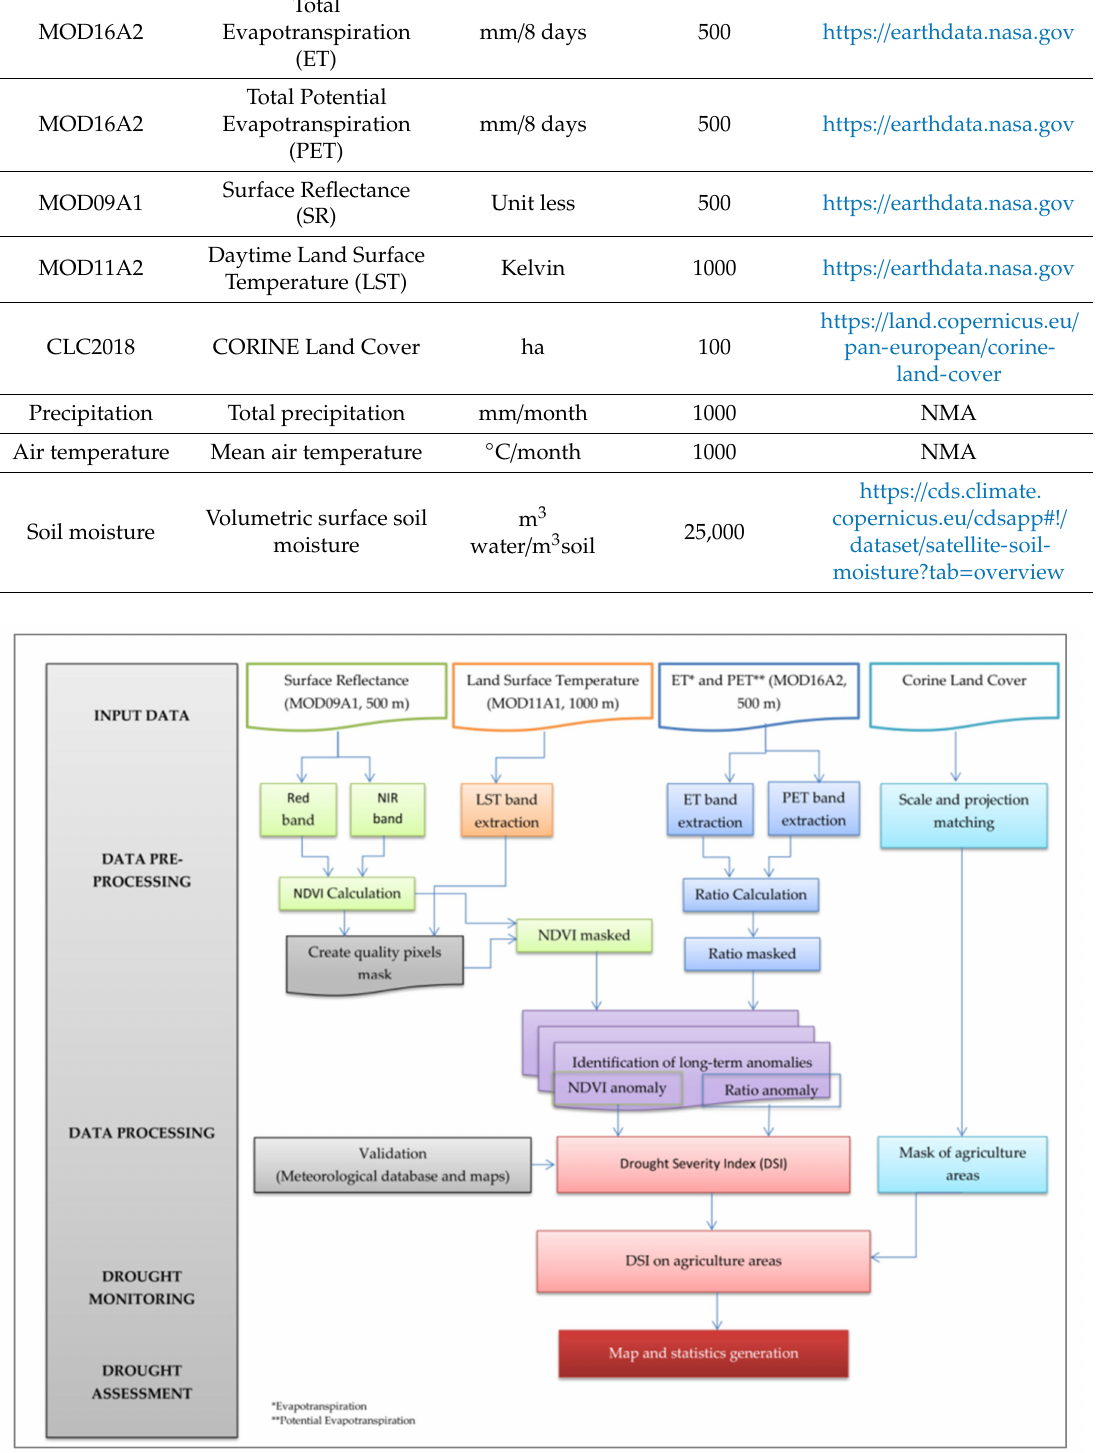
Figure 2. Flowchart for Drought Severity